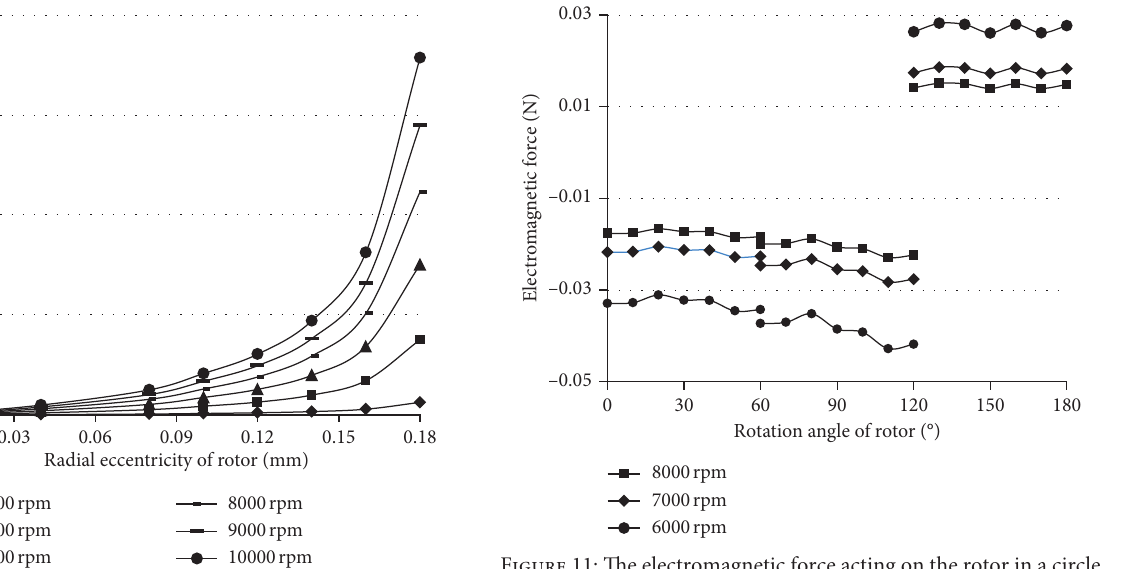
Figure 9: HD bearing force in different speeds and radial ec- centricity of the rotor.